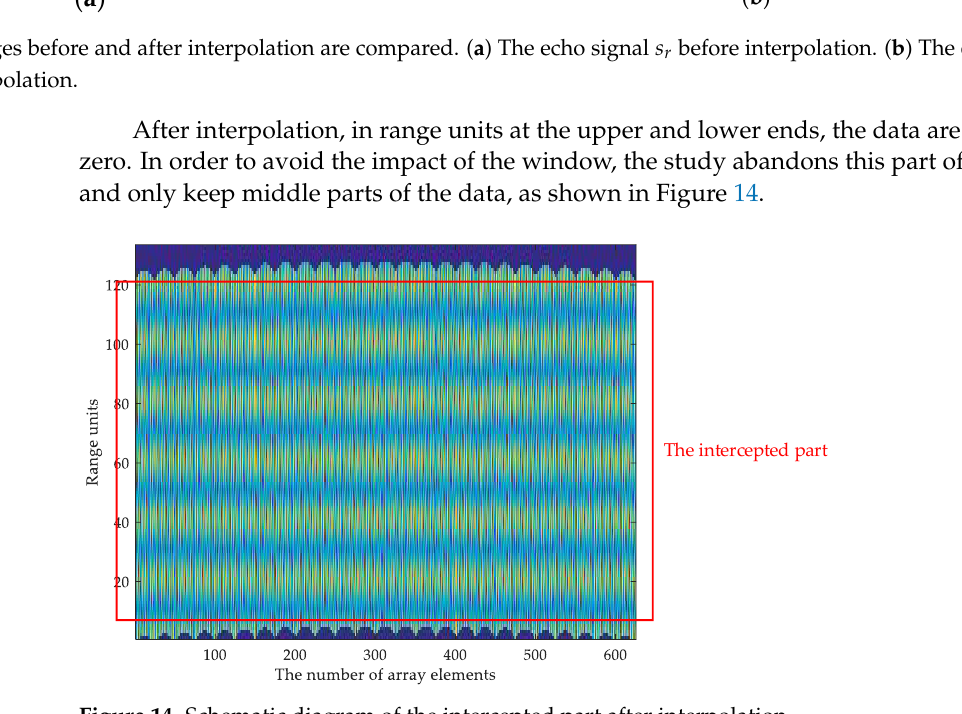
s before interpolation. ( b ) The